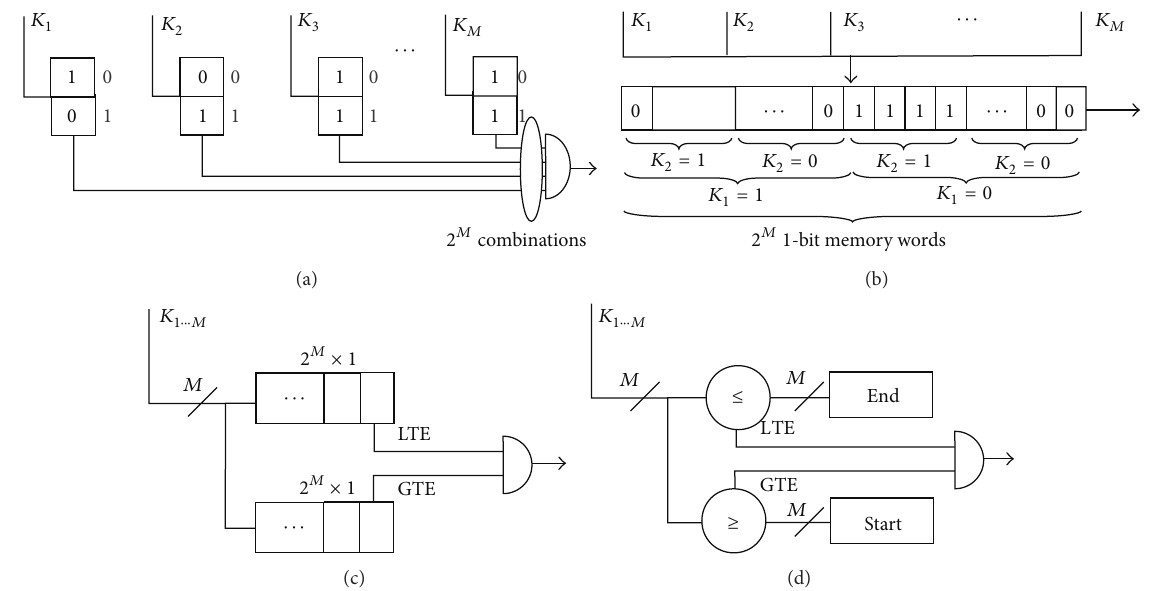
Figure 7: 1-rule lookup: (a) register-based TCAM emulation (no address expansion), (b) memory-based interval (full address expansion), (c) memory-based bounds, and (d) logic-based bounds. ranges (see Section 1) must be mapped into multiple prefixes which can expand to 𝑀 entries for keys of width 𝑀